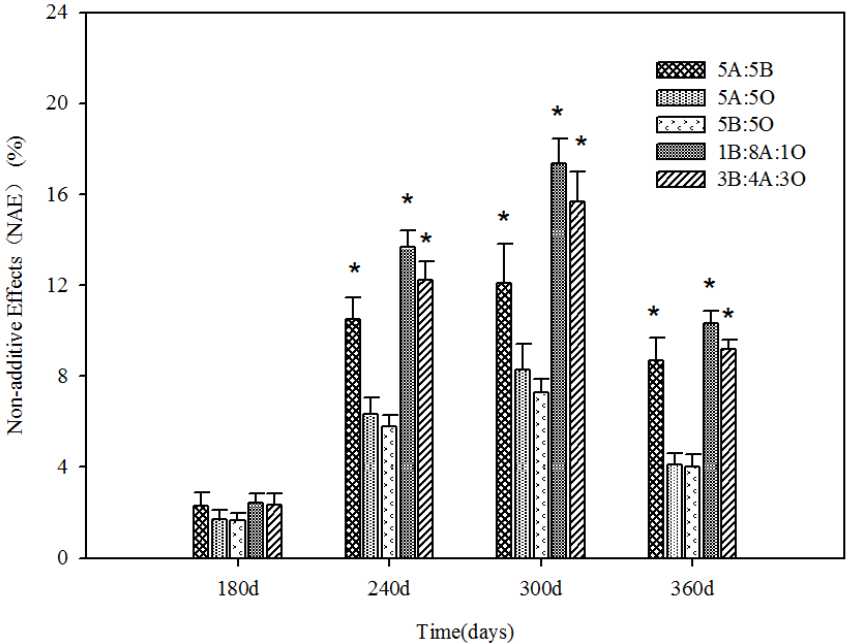
Figure 1. Non-additive effects (NAE) on mass remaining in all litter mixture treatments over time. t -tests were used to check whether NAE was significantly different from zero, indicated by * . Bars indicate SE ( n =